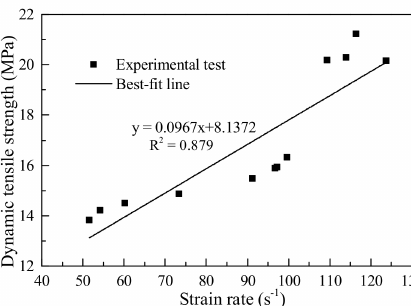
Figure 5. Dynamic tensile strength of concrete at different strain rates.